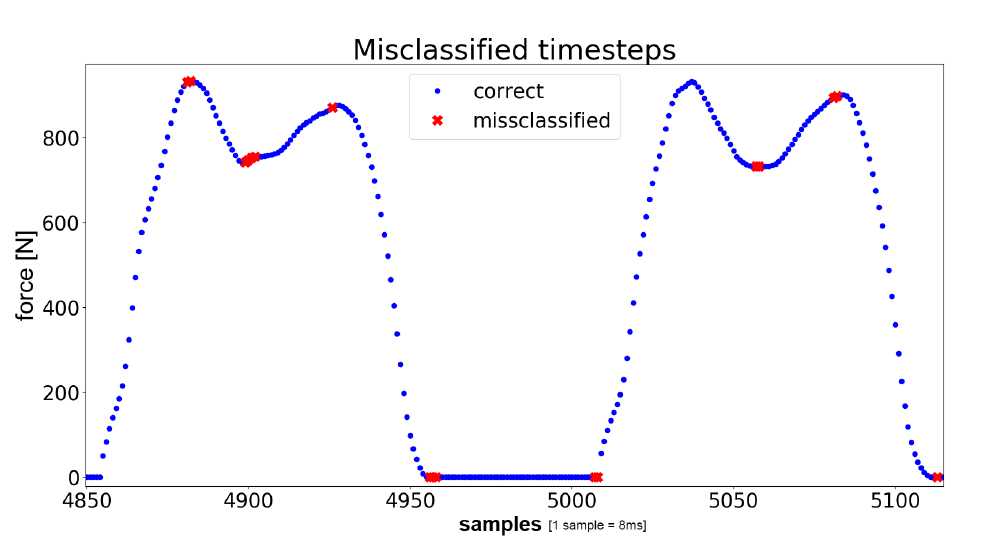
Figure 6. Correct (blue dots) and misclassified (red crosses) data samples in the label data. The y-axis indicates the total cumulated force [N].